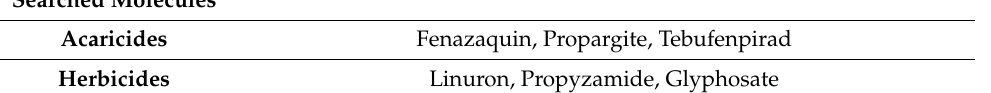
Table 1. Chemical compounds searched by GC-MS/MS and LC-MS/MS in pollen and honey. Searched